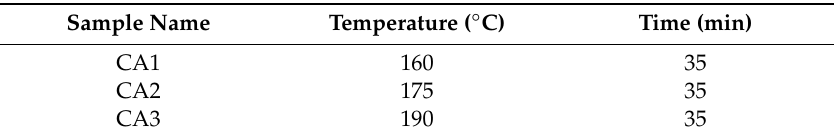
Table 1. Pre-treatment conditions.